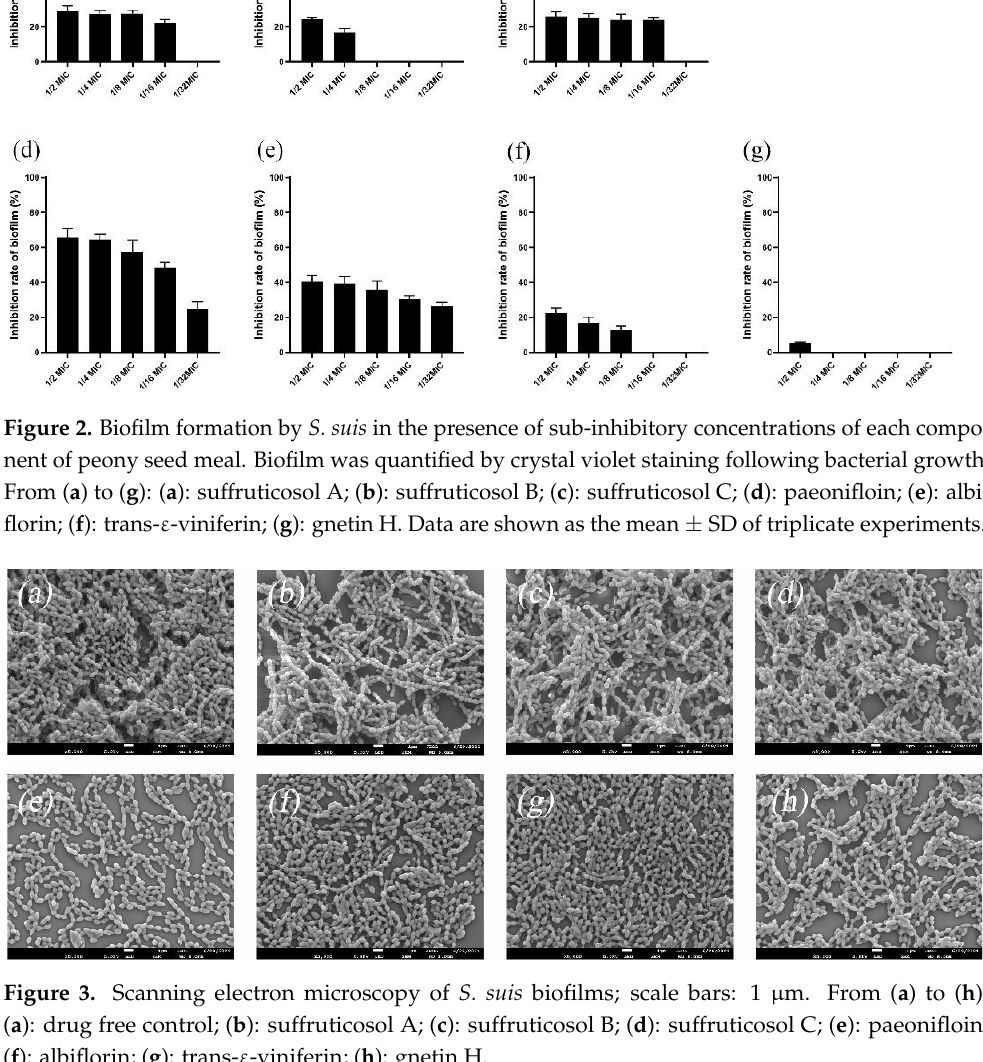
Figure 2. Biofilm formation by S. suis in the presence of sub-inhibitory concentrations of each com-